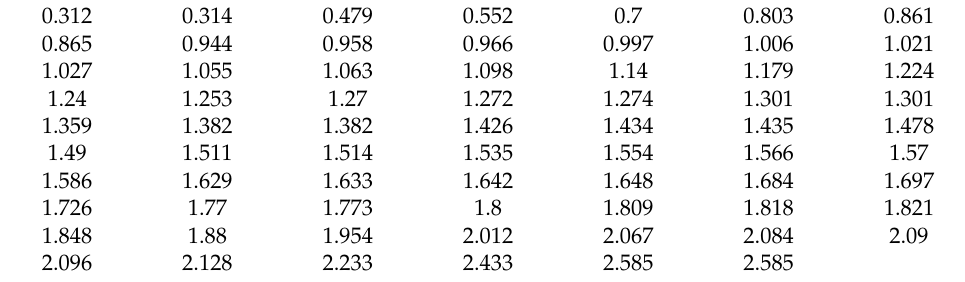
Table 10. Breaking strength of a single carbon fiber with a gauge length of 20 mm.